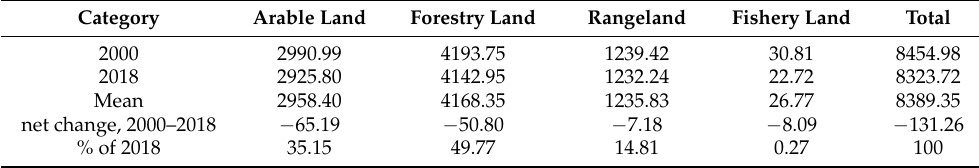
Table 3. Agricultural land extent (km 2 ) between 2000 and 2018.